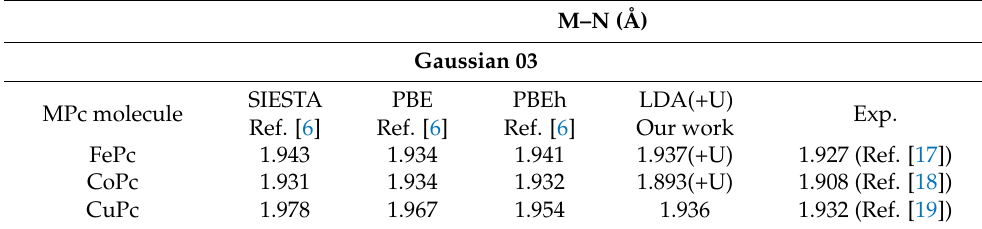
Table 1. Optimized bond lengths between the 3d metal center (M) and the nearest nitrogen (N) atoms for Fe-/-Co-/-Cu-phthalocyanines in the gas phase. The experimental values are also given for